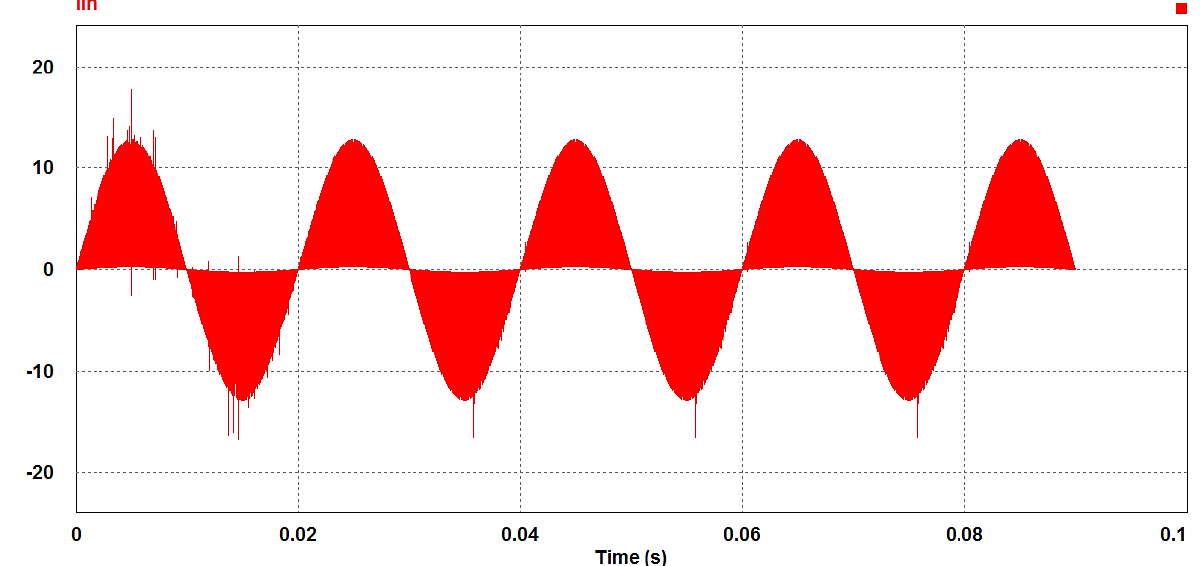
Figure 4. The input current waveform of IH system without Boost PFC